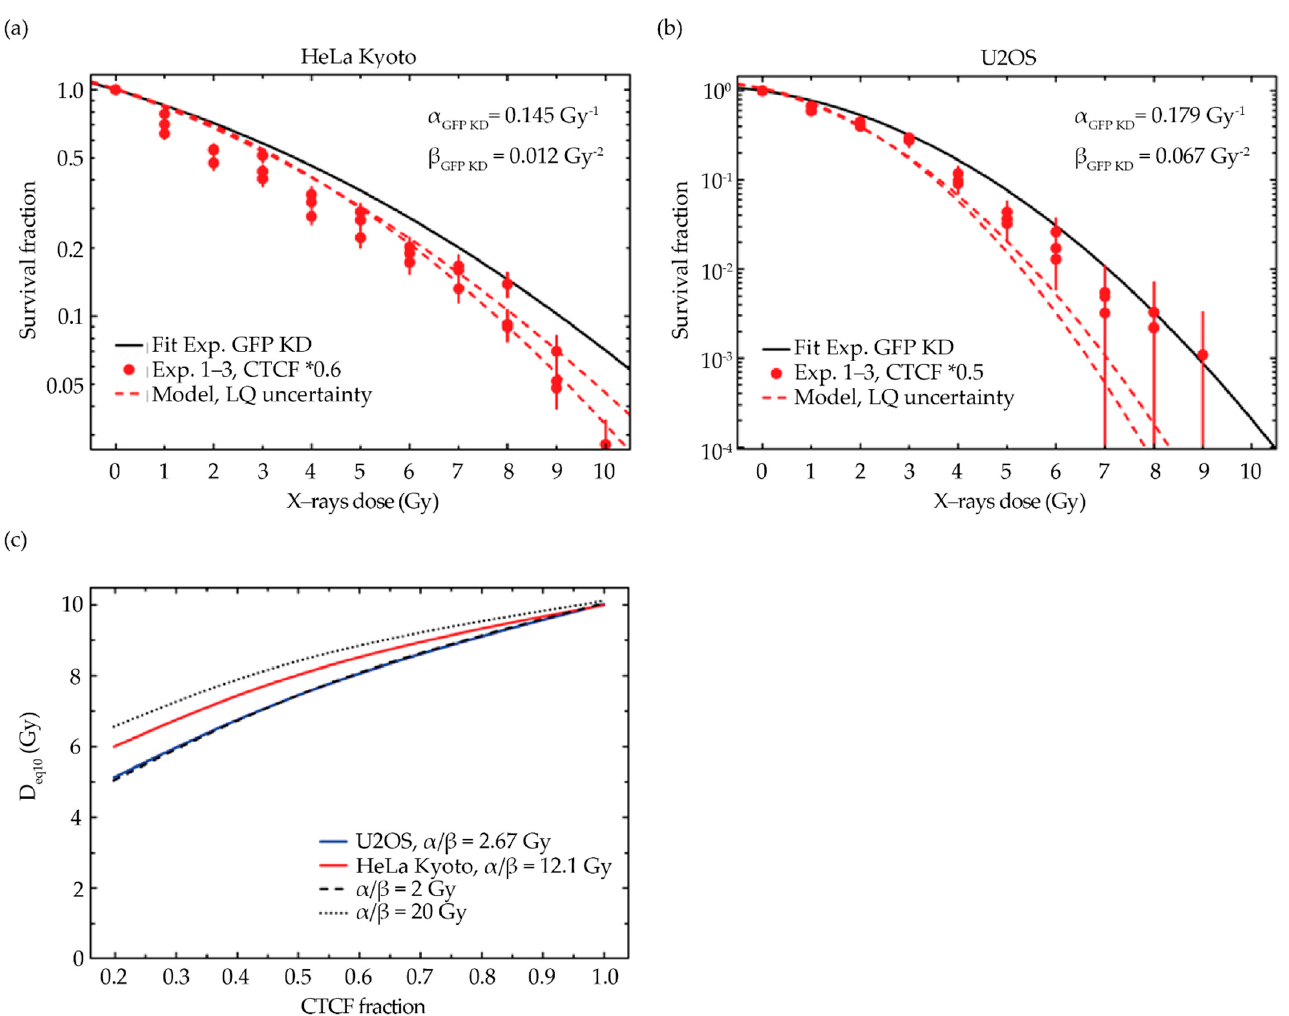
Figure 6. Validation of GLOBLE modeling predictions: uncertainty analysis of the linear quadratic (LQ) fitting curve and analysis of the cell line-related dependency on the impact of CTCF on radiosensitivity. ( a , b ) Impact of the uncertainty of the fitted LQ-parameters for the reference condition on the predicted survival curve for CTCF depletion to 60% in HeLa Kyoto ( a ) and 50% in U2OS cells ( b ), respectively. ( c ) Impact of the cellular system on the expected change in the sensitivity by CTCF depletion. Besides the model predictions for the two cell lines used in this study, additional calculations were performed for hypothetical cell lines characterized by a very low α / β -ratio of 2 Gy ( α = 0.3 Gy − 1 , β = 0.015 Gy − 2 ) and a high α / β -ratio of 20 Gy ( α = 0.3 Gy − 1 , β = 0.0015 Gy − 2 ).